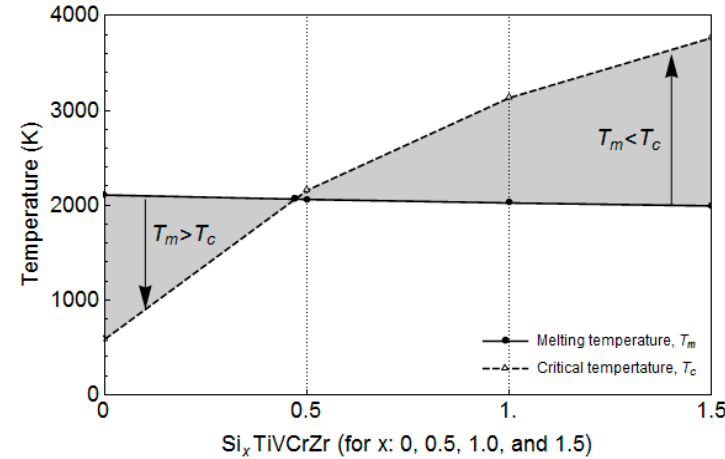
Figure 1. The values of the critical temperature for the suppression of intermetallic formation and the rule of mixtures estimated melting point for the alloys considered here (Si x TiVCrZr ( x = 0, 0.5, 1,